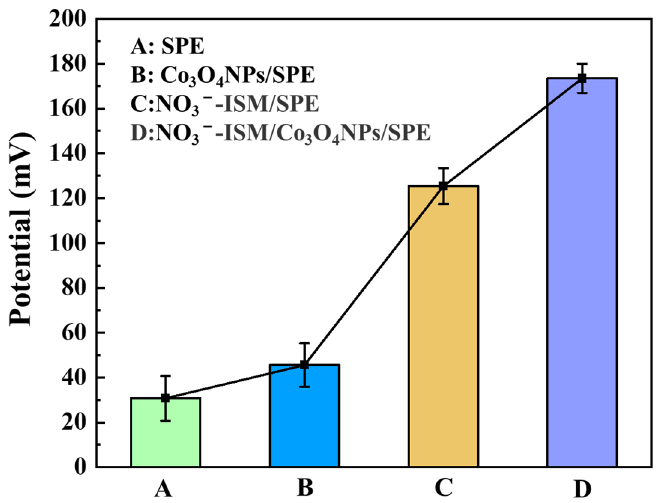
Figure 10. Potential response comparison of the SPE, Co 3 O 4 NPs/SPE, NO 3 − -ISM/SPE and NO 3 − - ISM/Co 3 O 4 NPs/SPE.